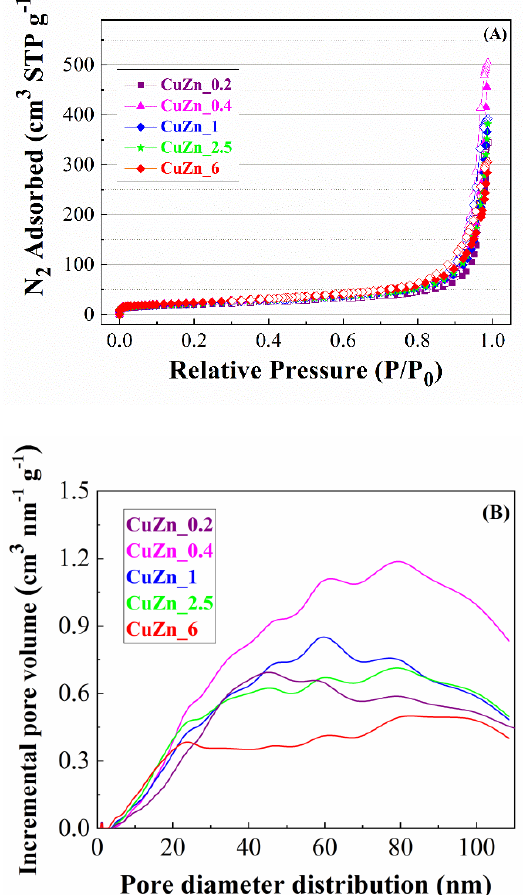
Figure 7. N 2 adsorption-desorption isotherms at −196 ° C ( A ) and pore size distribution estimated by DFT method ( B ) for CuZn_X catalysts.